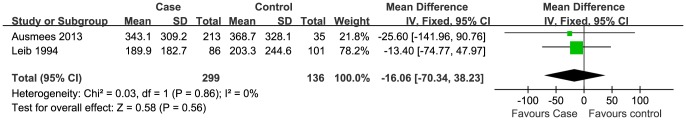
Forest plot showing the meta-analysis outcomes of the effect of CP/CPPS on total sperm counts.